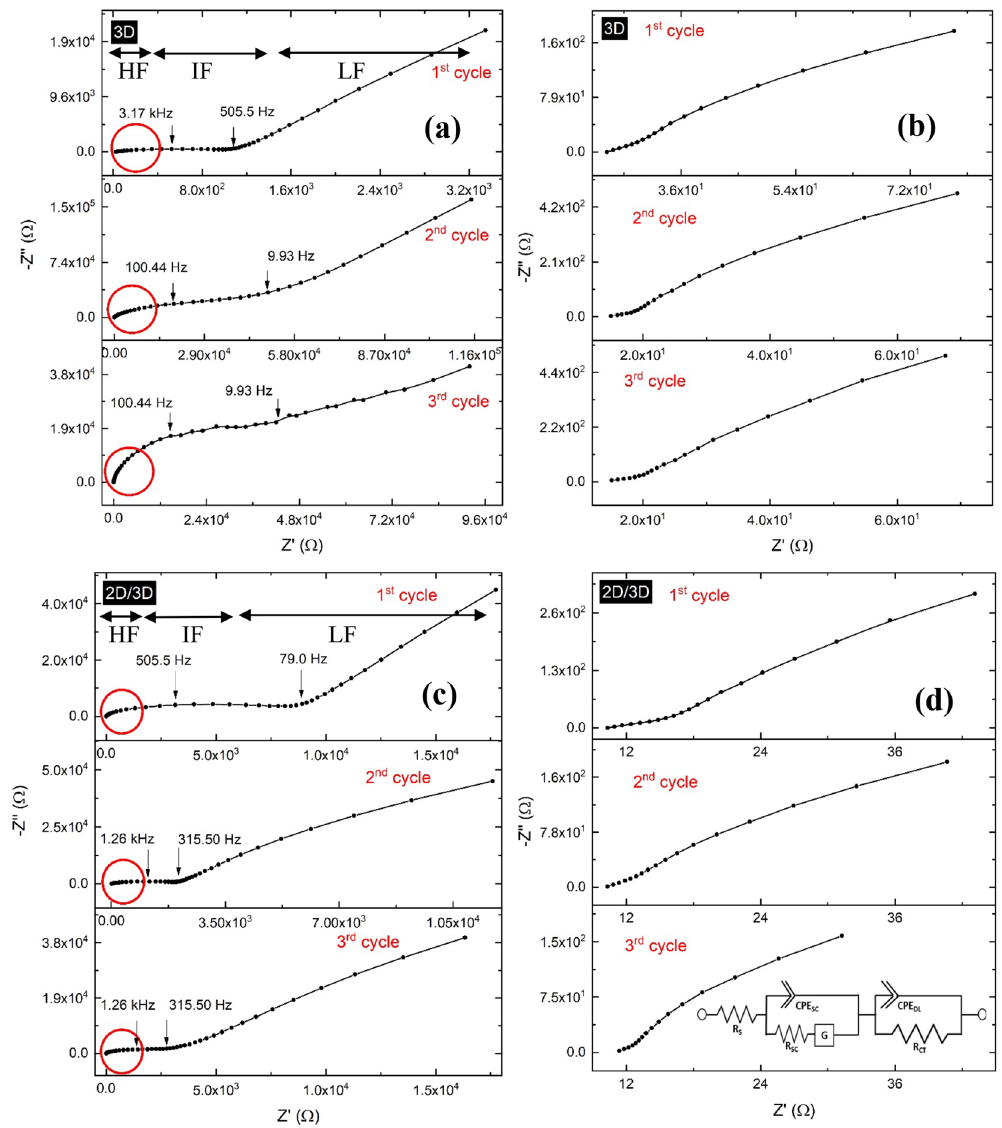
Figure 4. Impedance spectra of (a) the 3D and (c) 2D/3D hybrid PSCs recorded in three different cycles during the 5000 h with the time difference of 2500 h. (b,d) represent the HF region of the corresponding spectrum. These spectra were recorded under dark at 10 mV AC perturbation and 0 V DC bias.